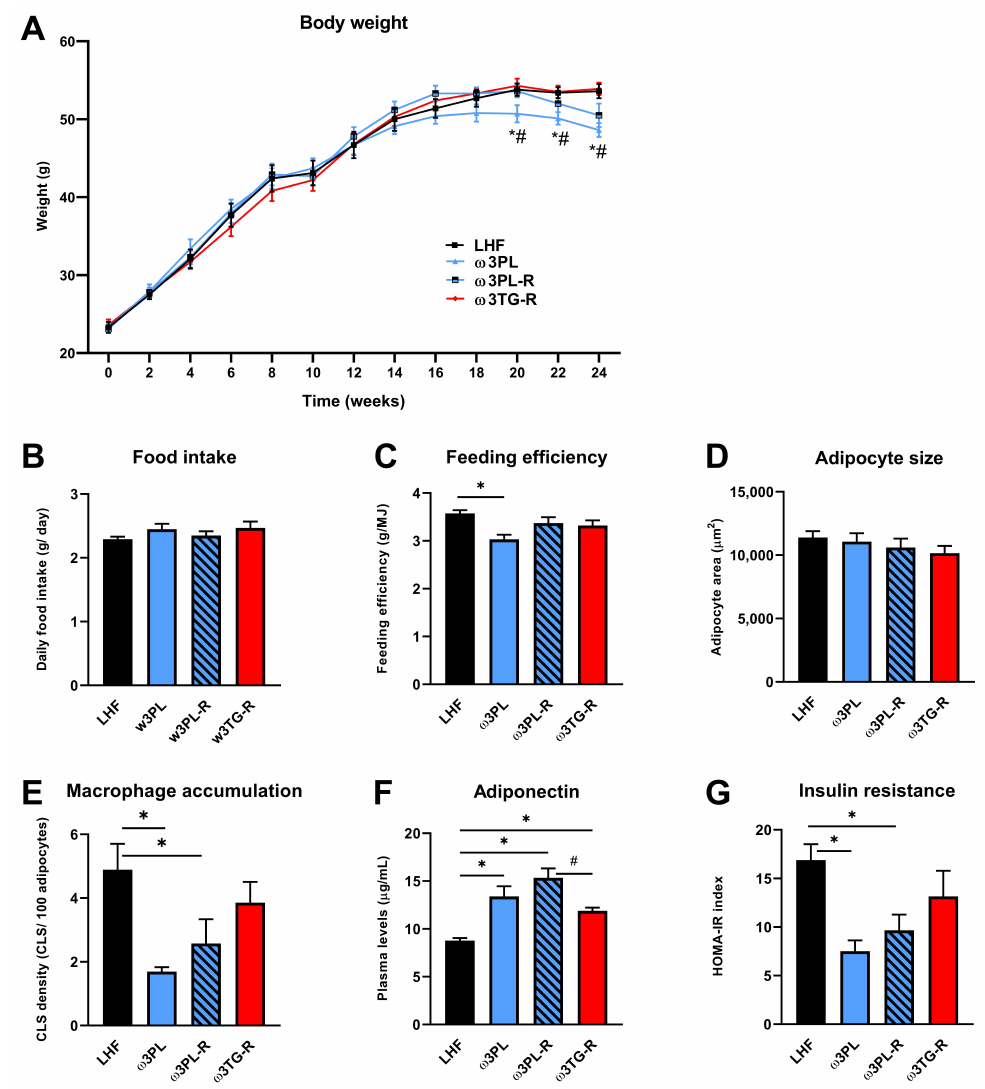
Figure 2. The effect of omega-3 PUFA supplementation on parameters related to energy balance, adipose tissue health and insulin sensitivity: changes in body weight during the study ( A ), average daily food intake ( B ), feeding efficiency ( C ), average size of adipocytes ( D ) and macrophage accu- mulation in epididymal WAT ( E ), plasma adiponectin levels ( F ), and insulin resistance based on the HOMA-IR index ( G ). Data are means ± SEM ( n = 7–8). *, significant effect of omega-3 PUFAs (vs. LHF); #, significant difference from ω 3TG-R (One Way ANOVA or